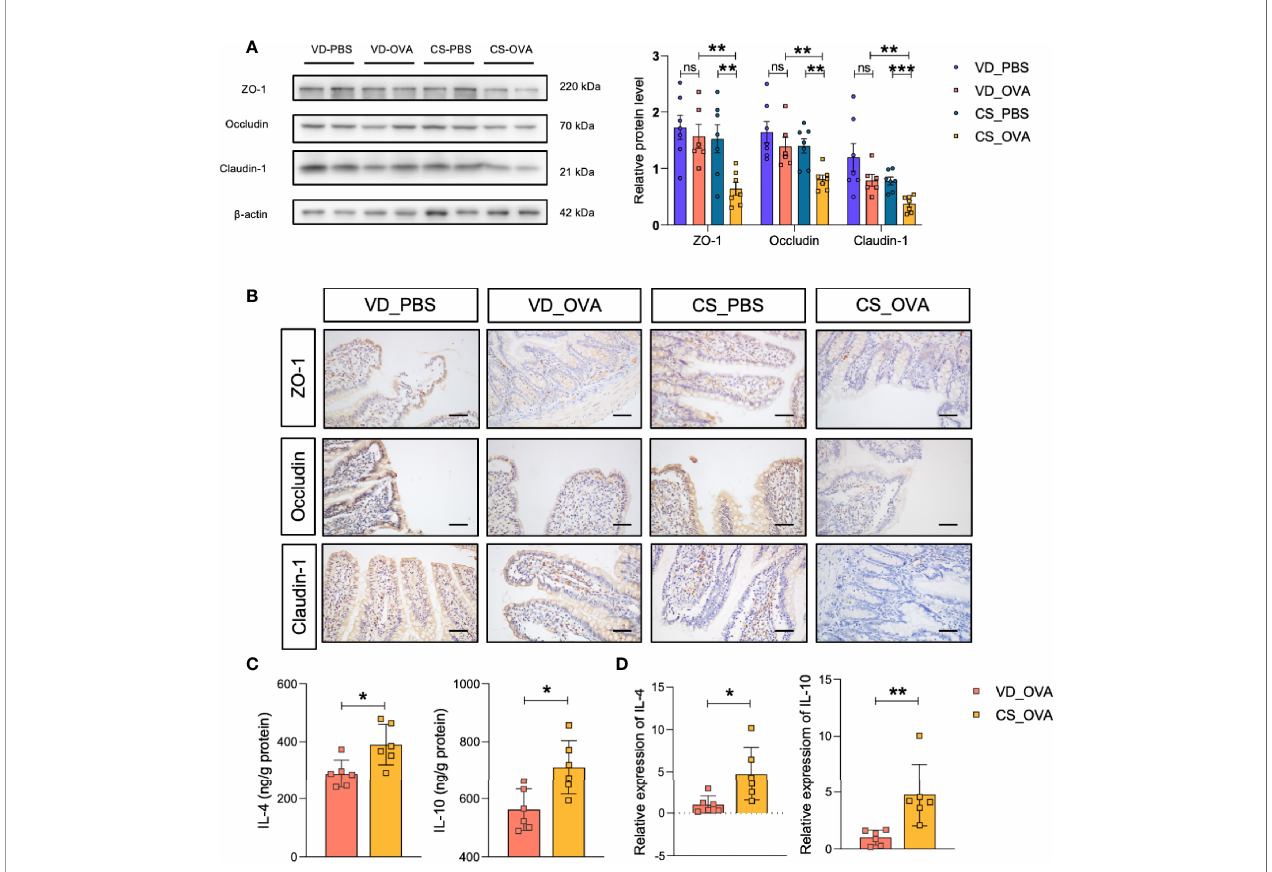
FIGURE 2 | CS dysregulates the expression of tight junction proteins and upregulates the levels of Th2 cytokines. (A) Western blot analysis of the tight junction proteins ZO-1, occludin, and claudin-1 in the ileum of four groups. b -actin was used as the internal control (left panel). Grayscale statistics of tight junction proteins relative to b -actin (Right panel). n ≥ 6. (B) Representative images of immunohistochemistry staining for ZO-1, occludin, and claudin-1 proteins. Scale bar = 50 m m. (C, D) IL-4 and IL-10 levels measured by ELISA (C) and q-RT-PCR (D) . n = 6. Data are expressed as means ± SEM. Statistical signi fi cance was determined by two-sided Student ’ s t-test or one way ANOVA, * P < 0.05, ** P < 0.01, *** P < 0.001; ns, no signi fi cance; VD, vaginal delivery; CS, cesarean